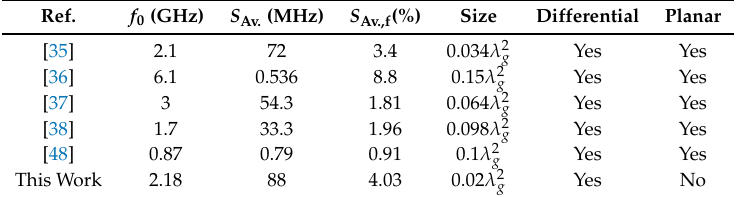
Table 2. Comparison between the performance of the designed frequency splitting sensor and the state-of-art